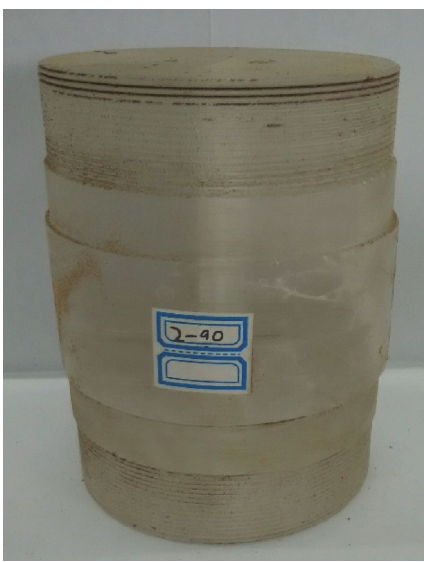
Figure 5: Fracture specimen model (2–90).